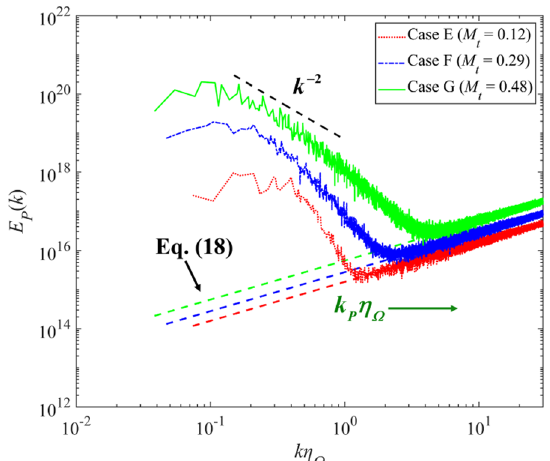
3 . The spectra of thermal fluctuations =